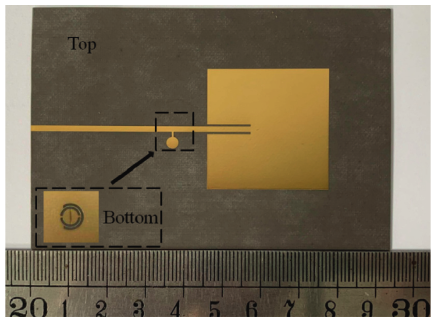
Figure 7: Photograph of the newly designed antenna. Inset: back view showing the novel DGS.